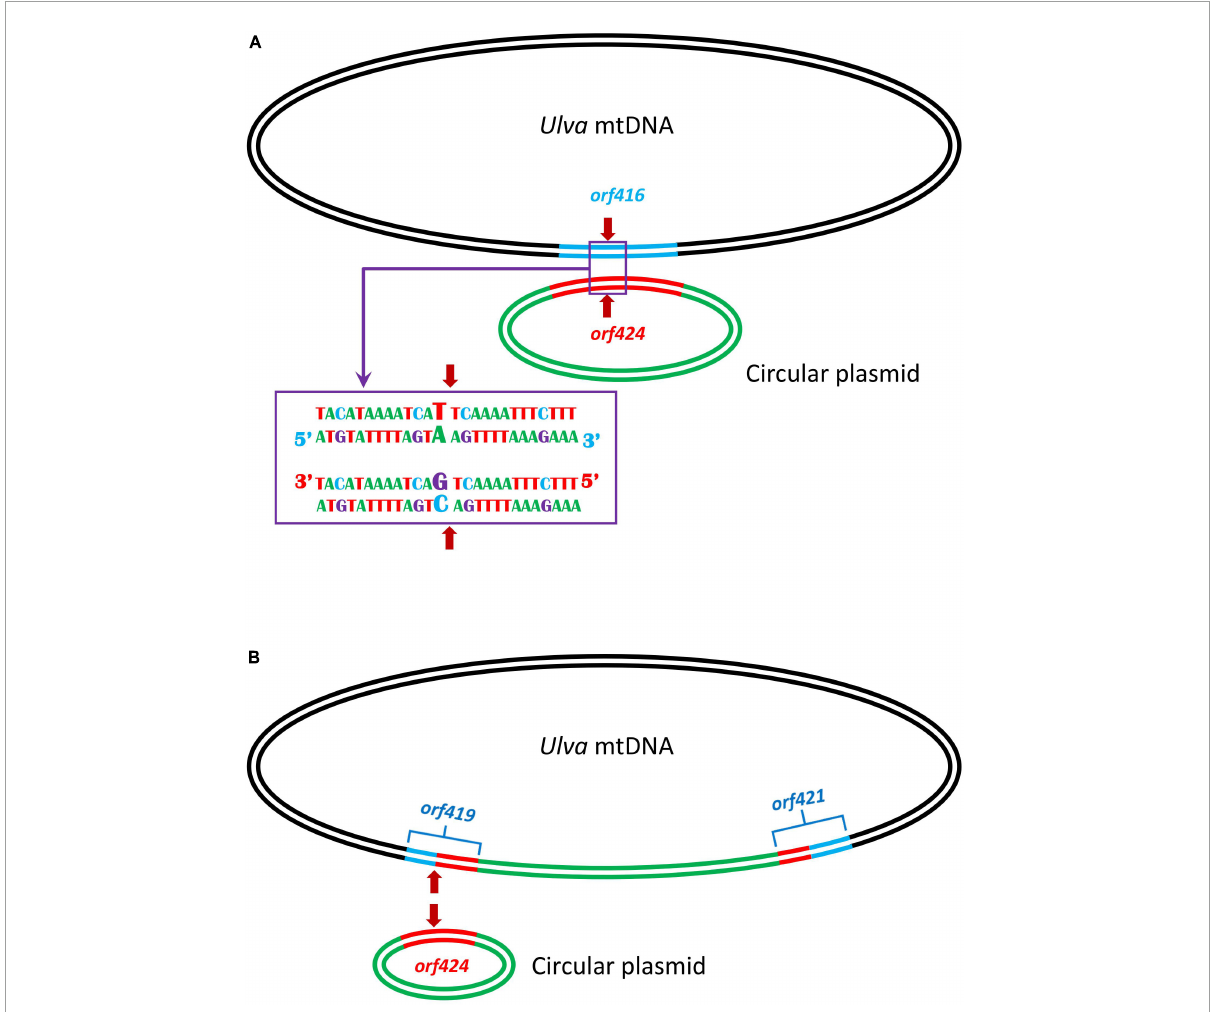
FIGURE4 Model of tandem integration of circular plasmid into the Ulva meridionalis mitochondrial genome. (A) Integration of circular plasmid involving homologous recombination. A 152-bp sequence is shared by orf416 in Ulva mtDNA and orf424 in circular plasmid, and the homologous sequences are nearly completely identical, except that there is only one base difference at the integration site (the 43rd base of homologous sequences). The red arrow shows the integration site. (B) After the first integration of the circular plasmid, two chimeric orf s ( orf419 and orf421 ) were formed, and the subsequent integration of circular plasmid is more likely to occur in orf419 which retained the only differential base at the integration